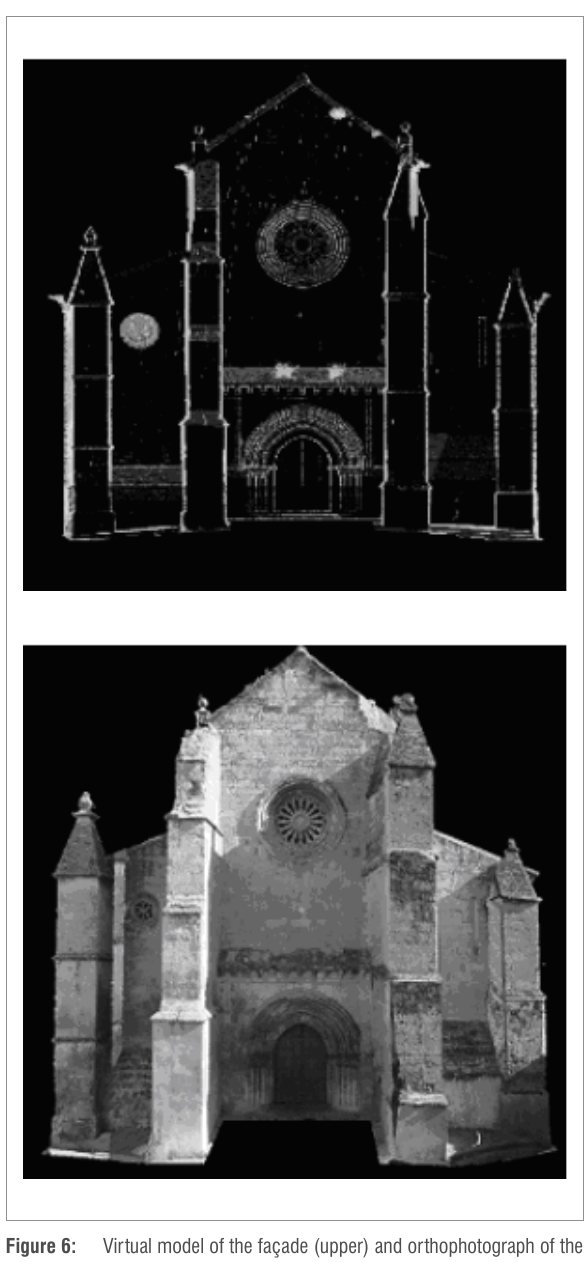
Figure 6: Virtual model of the façade (upper) and orthophotograph of the façade (lower) of the Santa Marina